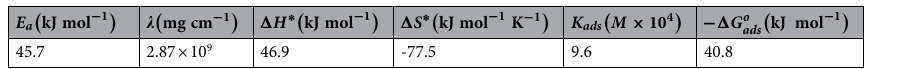
Table 2. Thermodynamic parameters for MS corrosion in 1 M HCL with the addition of 0.5 mM nonanedihydrazide.